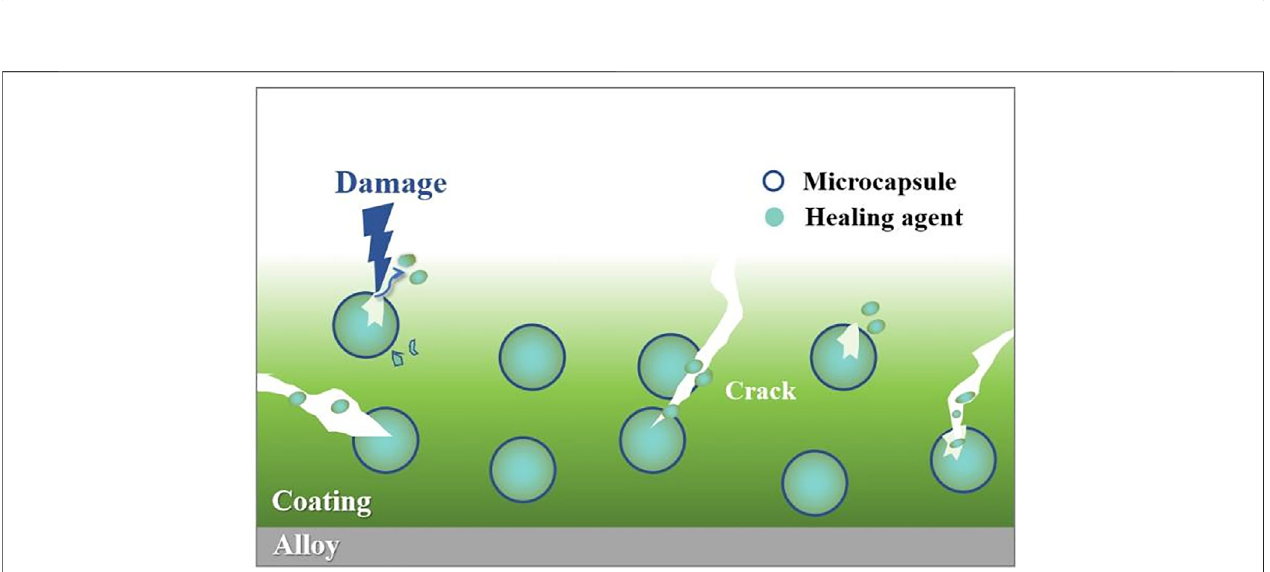
FIGURE 6 | Schematic diagram of natural release method of microcontainers loaded healing